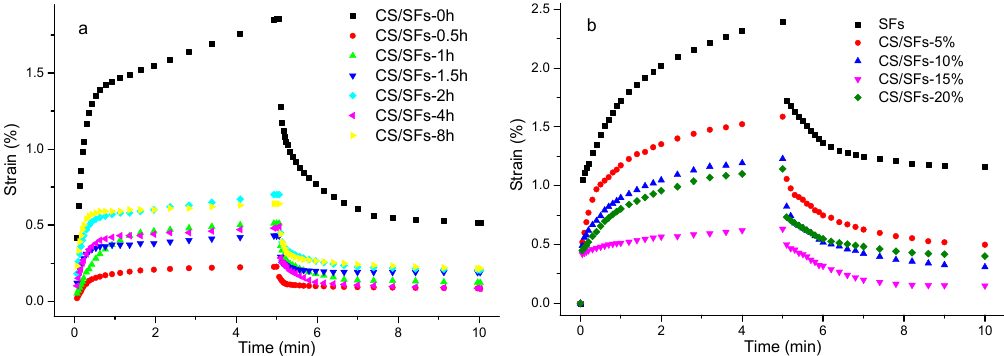
Figure 4. Creep-recovery versus time curves of the CS/SF with different ball grinding times ( a ) and different addition amounts ( b ).